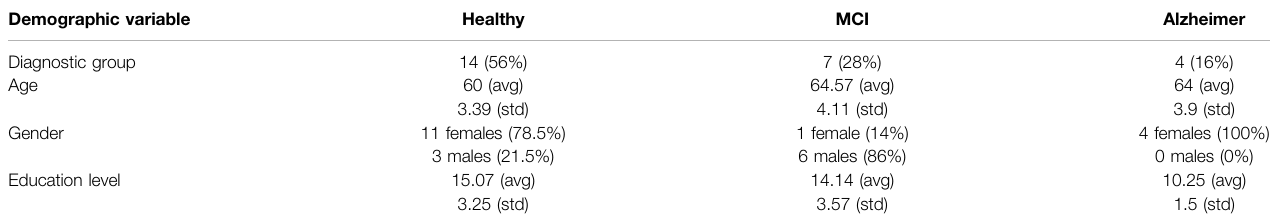
TABLE 3 | A demographic table with age, gender and education level for participants based on diagnostic group. Demographic variable